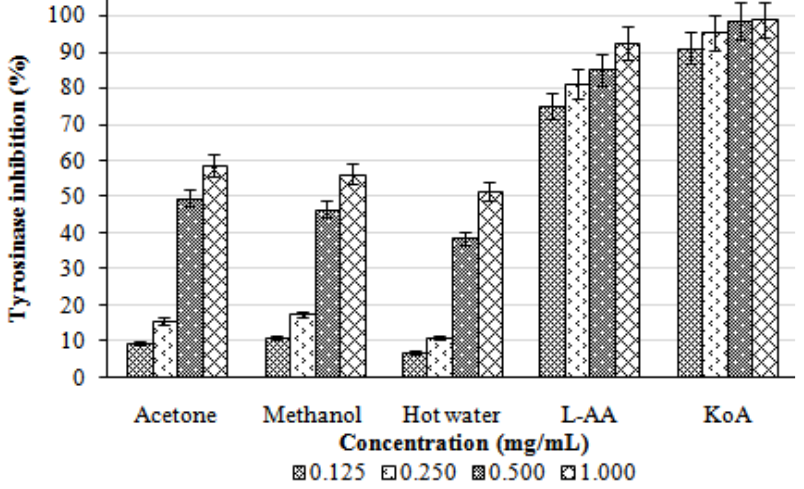
Figure 5. Tyrosinase inhibitory activity of various extracts from the fruiting bodies of Lentinus lepideus . Values expressed as means ± SD (n = 3); L-AA, L -ascorbic acid; KoA, kojic